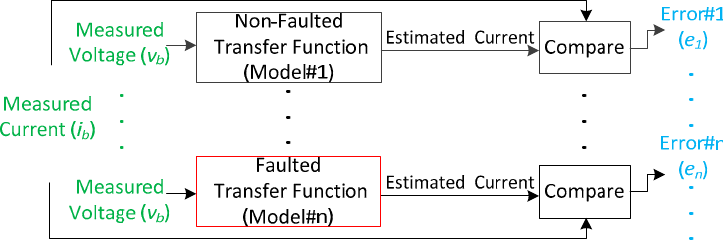
Figure 2. Microgrid fault-detection method.